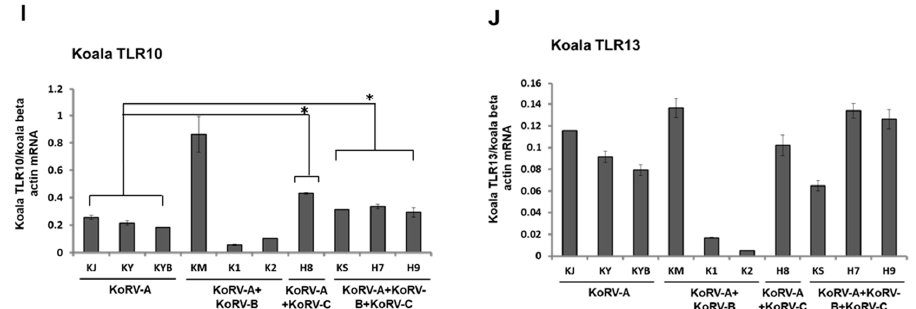
Figure 2. Expression profile of TLR mRNAs in koala peripheral blood mononuclear cells (PBMCs). Expression patterns of TLR2 ( A ), TLR3 ( B ), TLR4 ( C ), TLR5 ( D ), TLR6 ( E ), TLR7 ( F ), TLR8 ( G ), TLR9 ( H ), TLR10 ( I ), and TLR13 ( J ) mRNAs are indicated in koala PBMCs infected with different KoRV subtypes. Koala beta actin mRNA was used for normalization of the transcript levels of the TLRs. Statistical significance was calculated using the Student’s t -test and indicated by asterisks (* p < 0.05, ** p < 0.01). Data are presented as mean ± SD ( n = 2). KoRV-A positive only koalas were considered as the control.